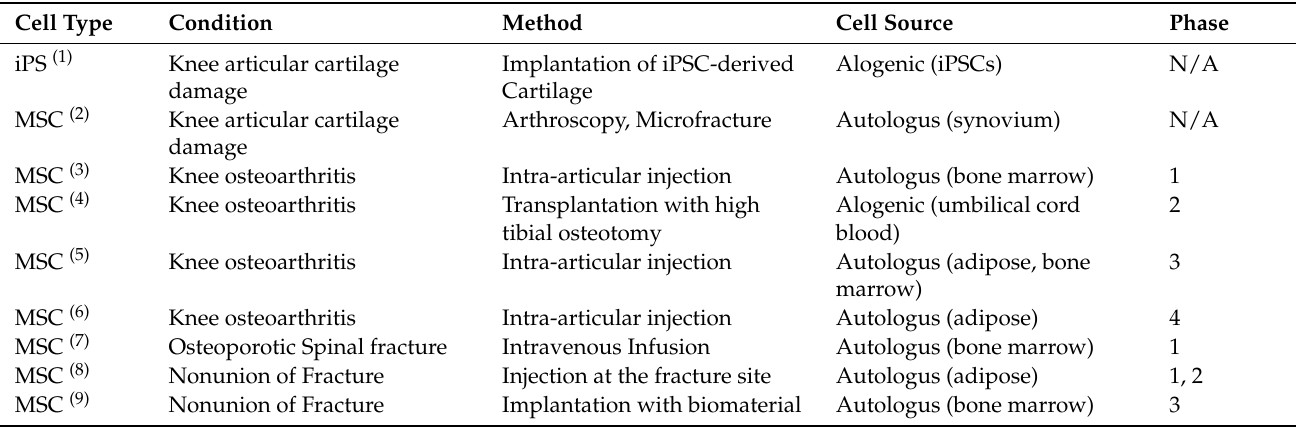
Table 1. Representative clinical trials for skeletal regeneration using stem cells. Ongoing studies were mainly picked up from UMIN Clinical Trials Registry (https://www.umin.ac.jp/ctr/index.htm) or Clinicaltrials.gov (https://clinicaltrials. gov/ct2/home) as of December 2020. Other trials can be found in the web sites. Each web link of which was listed here as